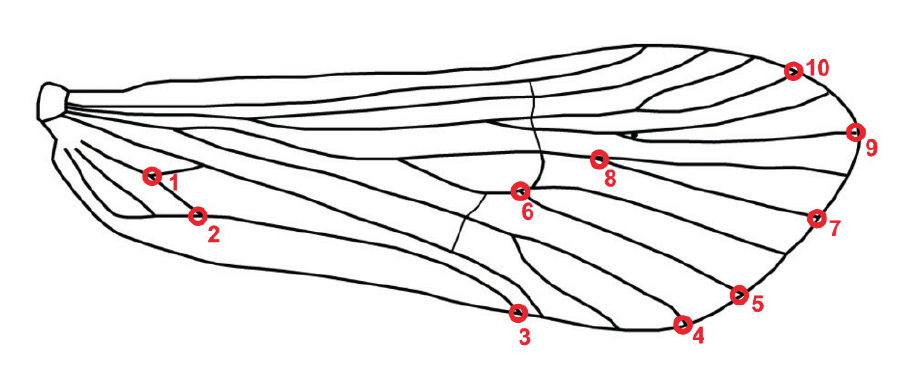
Figure 2. Forewing of Smicridea ( Rhyacophylax ) mesembrina showing the location of the selected land- marks (1–10). Table 1. Canonical variate analysis of Smicridea species mean wing shape. Number of individuals used of each species are indicated in diagonal. The percentage of correct classification above the main diagonal and Mahalonobis distances are below. The P-values < 0.05 for permutation tests (2000 permutation runs) are marked with asterisks